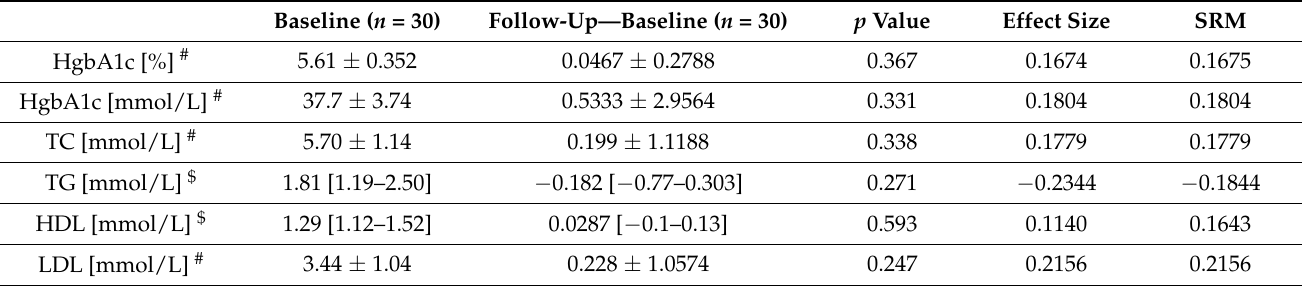
Table 2. Blood tests